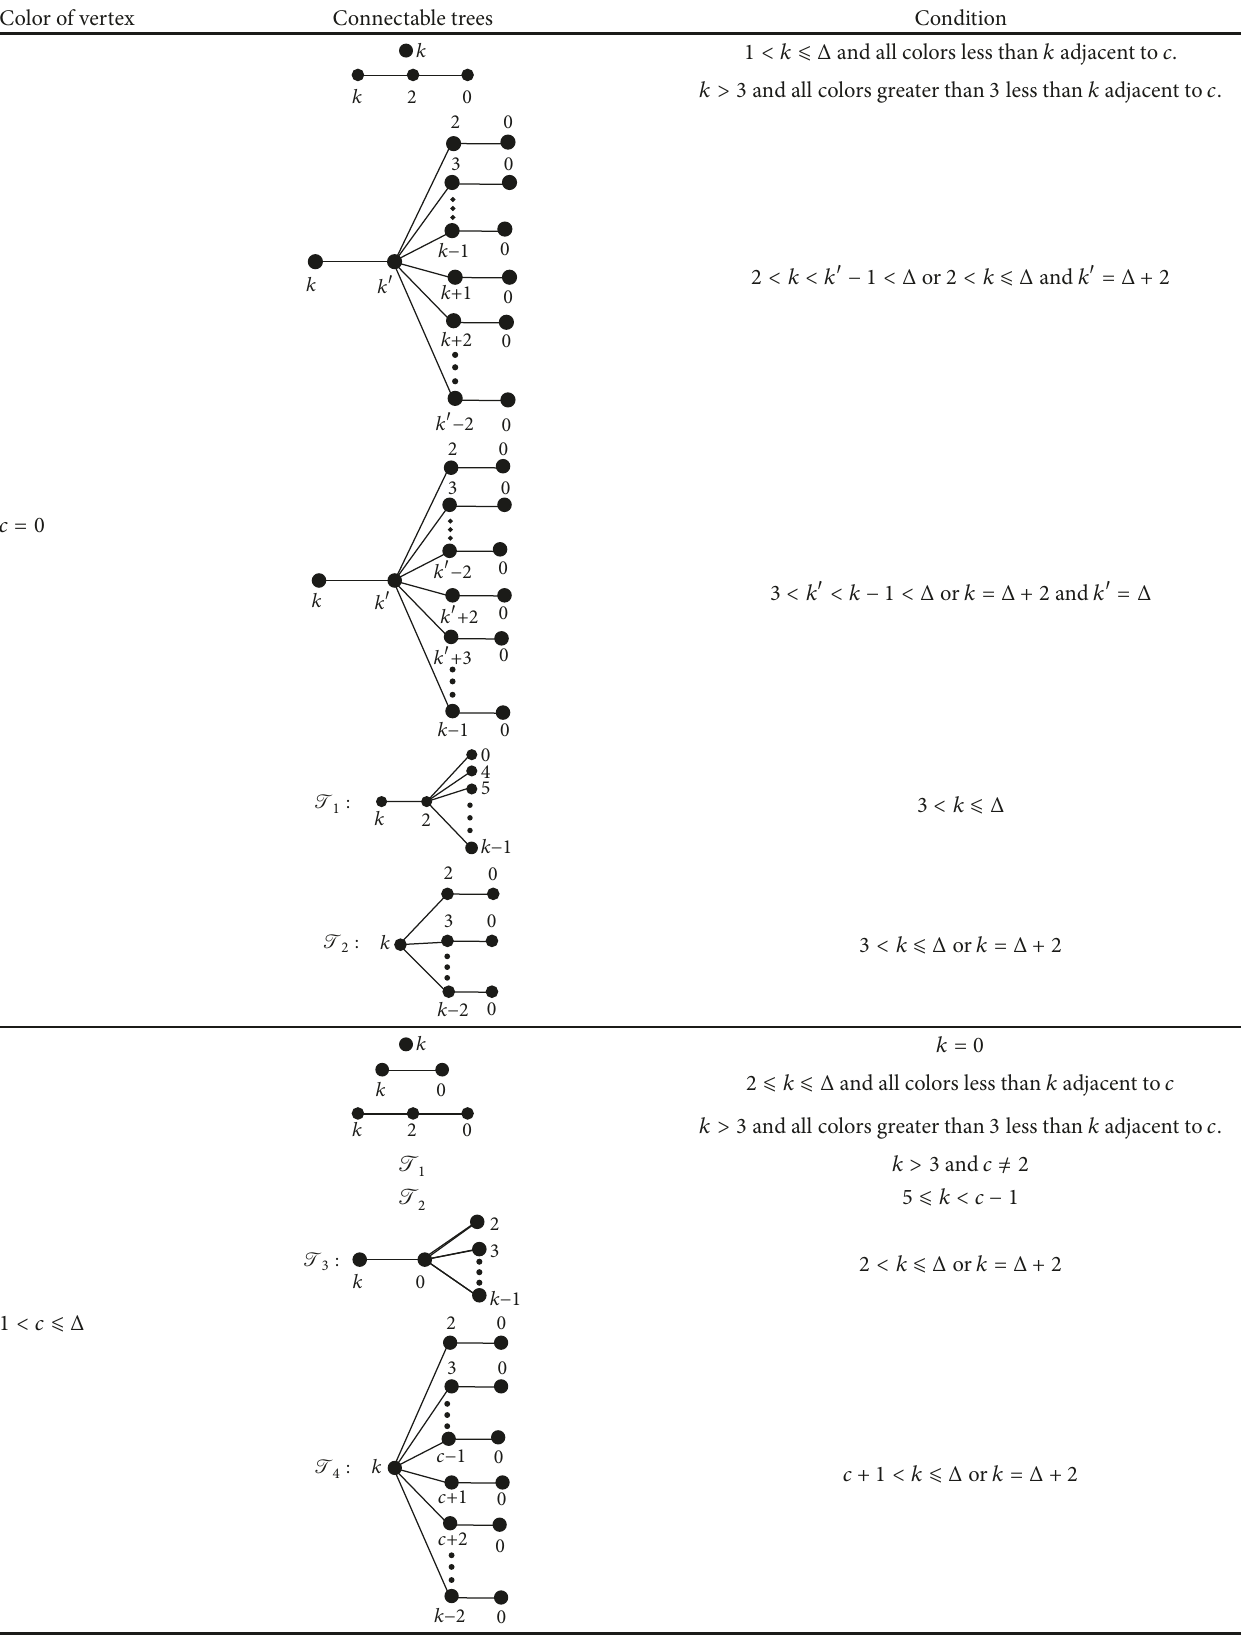
Table 2: Trees connectable to a vertex 𝑢 colored 𝑐 in a two-hole tree with 1 and Δ + 1 as holes. Color of vertex Connectable